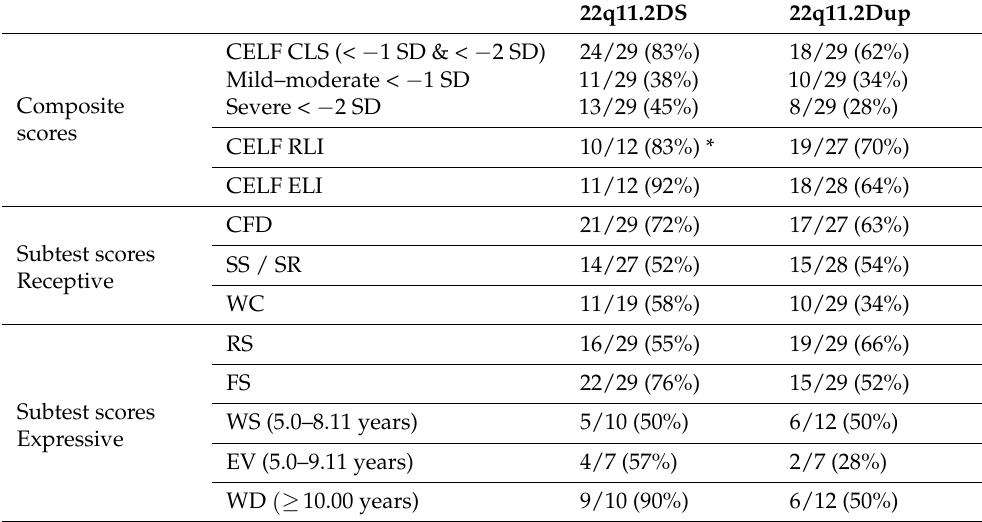
Table 4. Proportions of children with difficulties across composite and subtest scores on